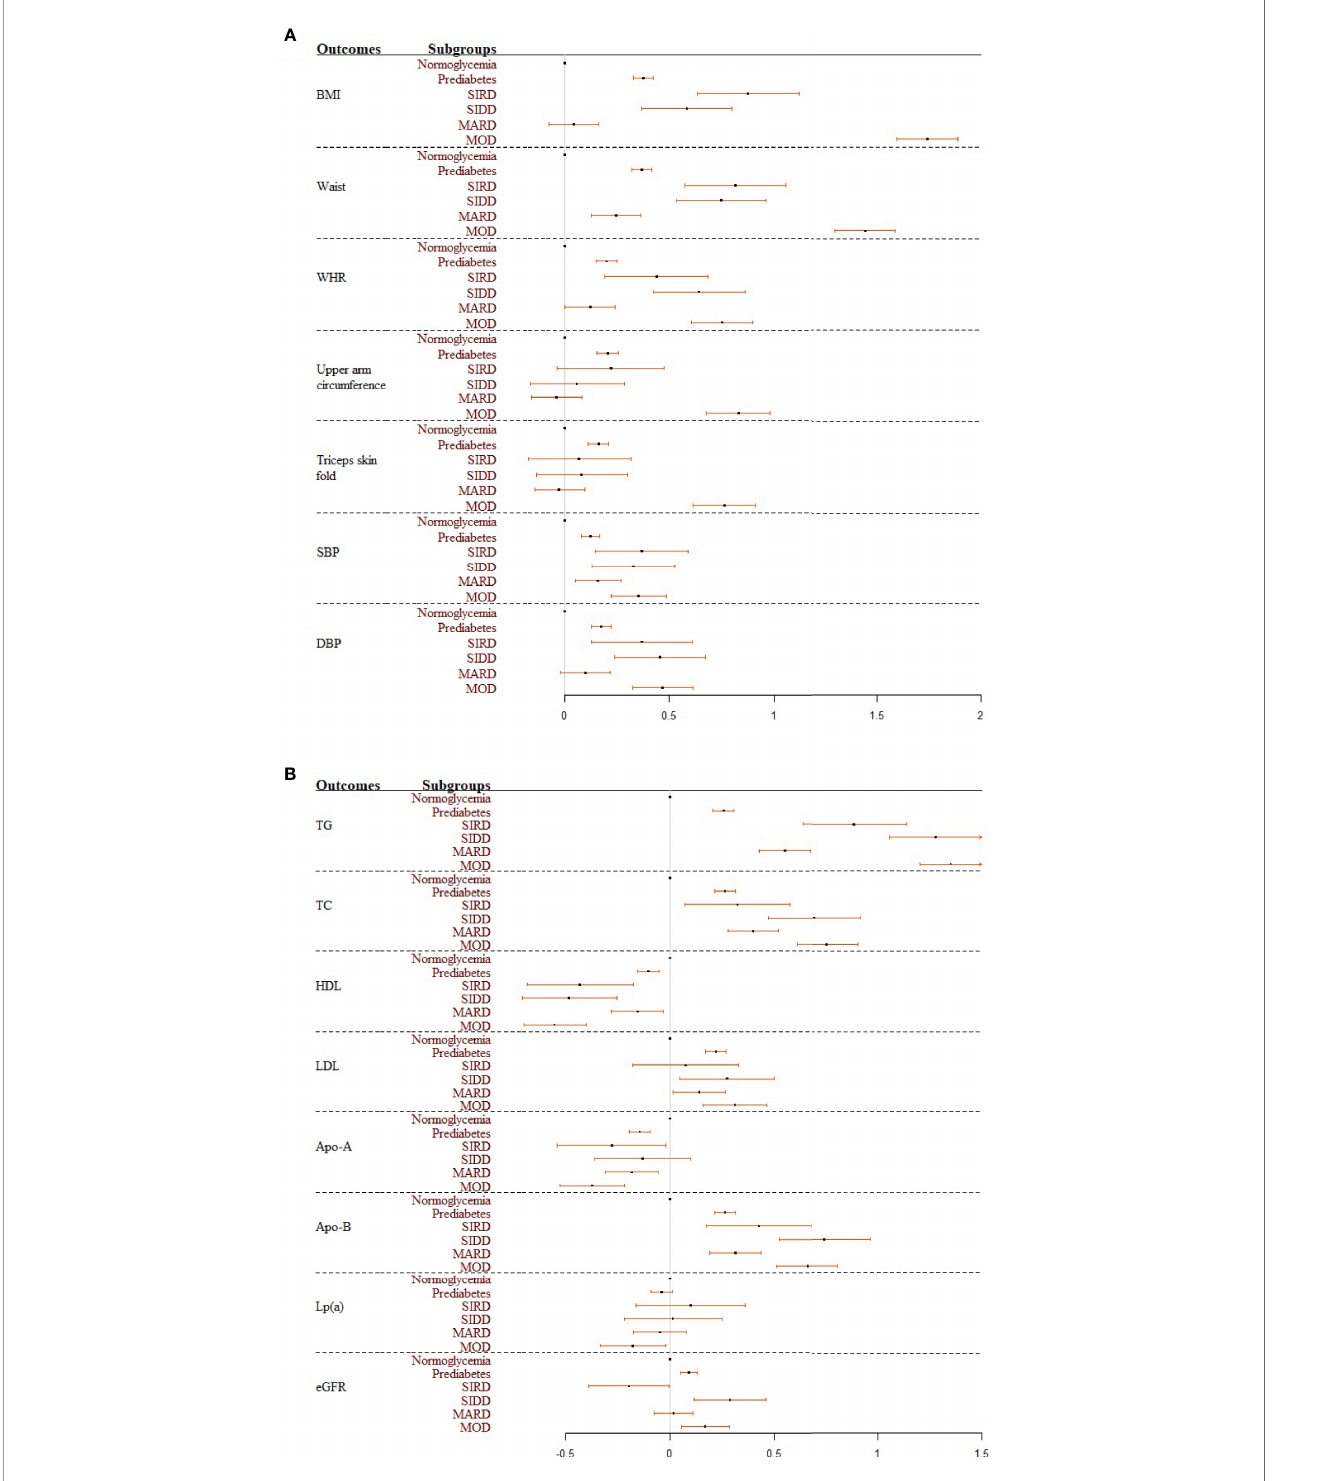
FIGURE 2 | (A, B) Forest plots summarizing the coef fi cients and 95% con fi dent intervals of standardized cardiovascular risk factors among glycemic statuses. Results were based on the full model. SIRD, severe insulin-resistant diabetes; SIDD, severe insulin-de fi cient diabetes; MARD, mild age-related diabetes; MOD, mild obesity-related